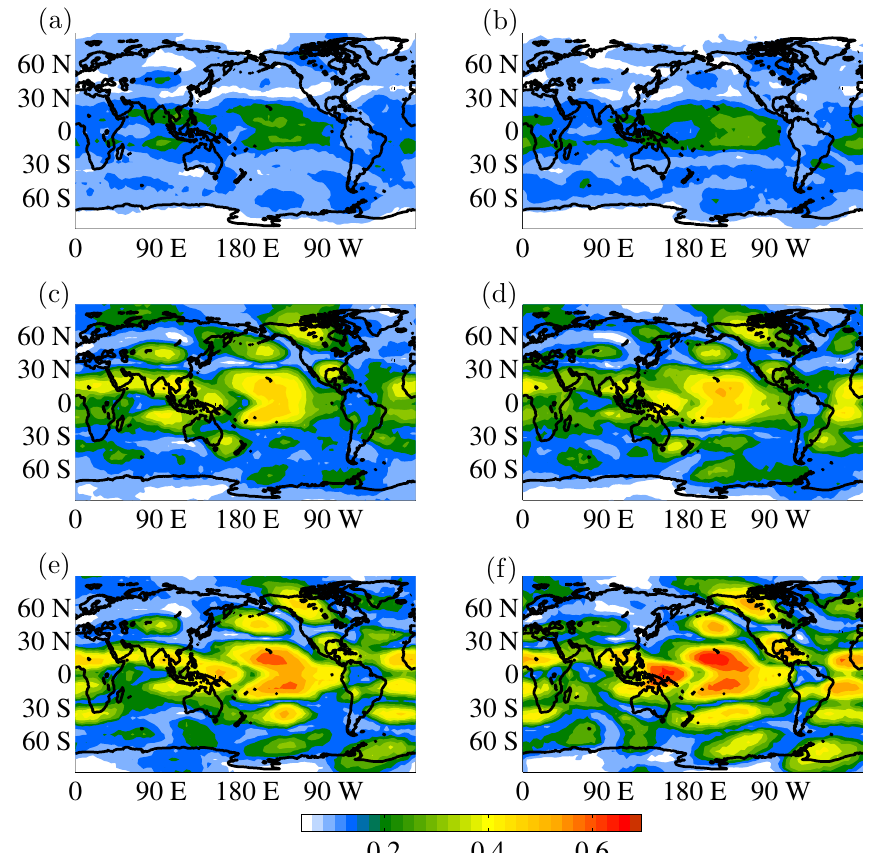
Figure 9. AWC maps of the ICTP-AGCM oceanically forced component. The networks are built by evaluating the mutual information with the BP methodology: 1t =1: (1901–1953) (a) and (1954–2006) (b) , 1t =4: (1901–1953) (c) and (1954–2006) (d) , and 1t =12: (1901–1953) (e) and (1954–2006) (f) .